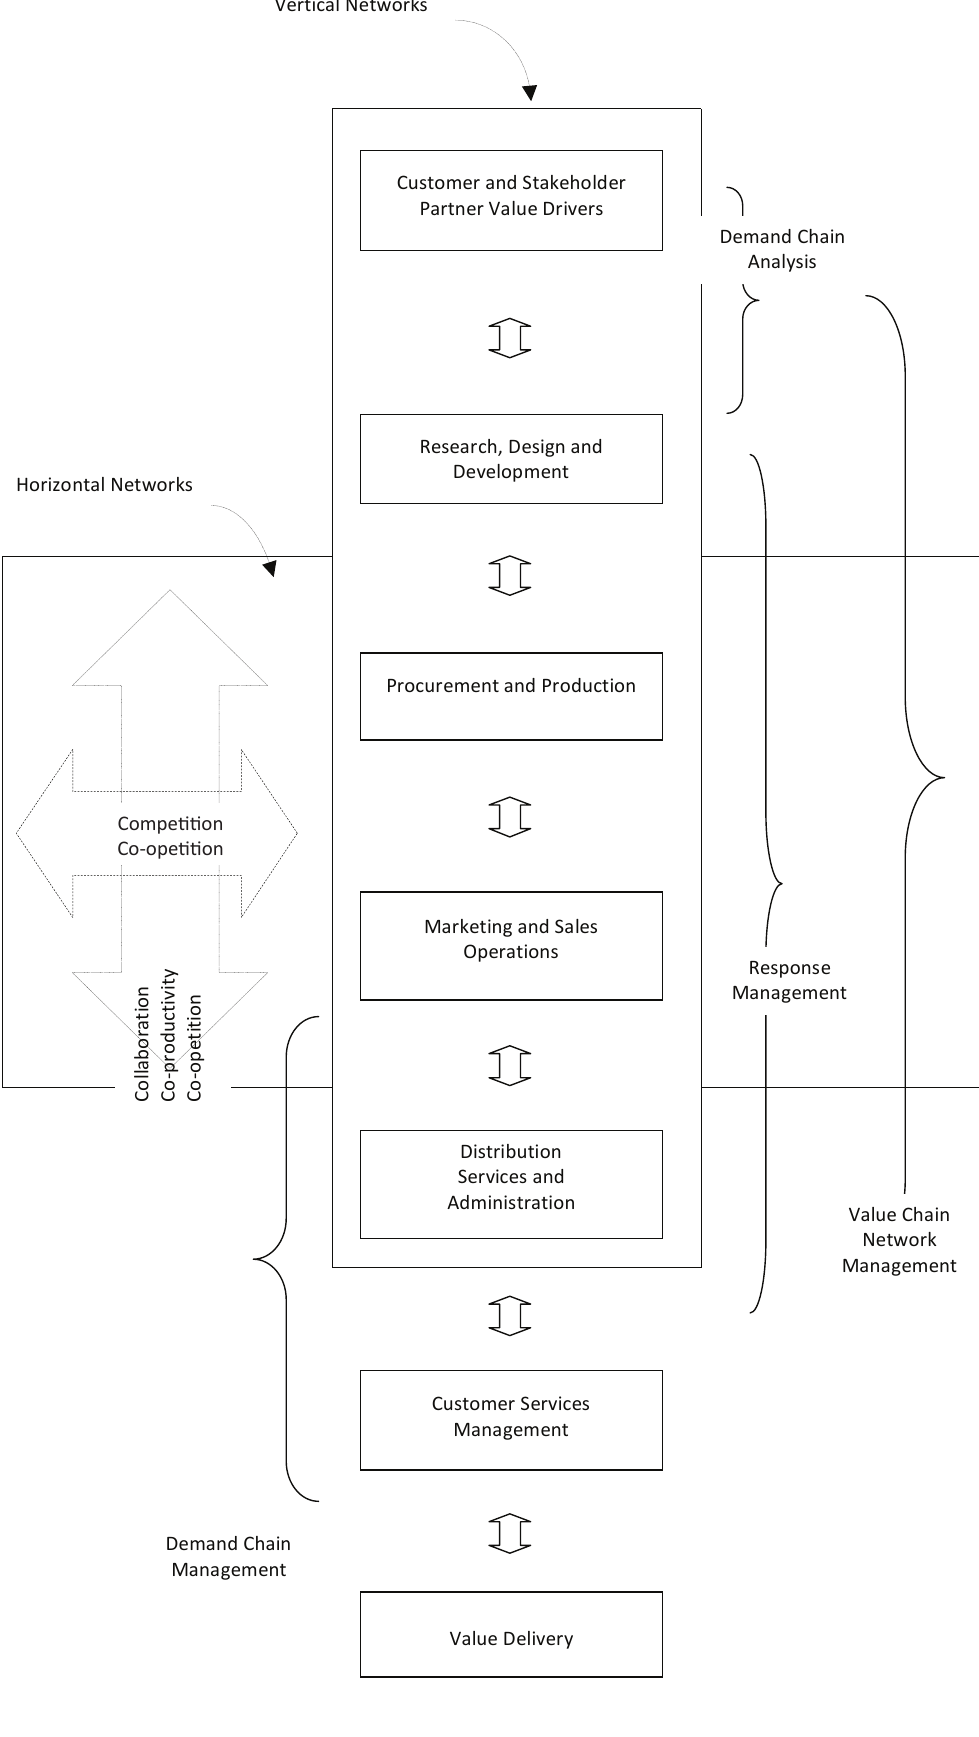
Figure 6: The evolving value chain network